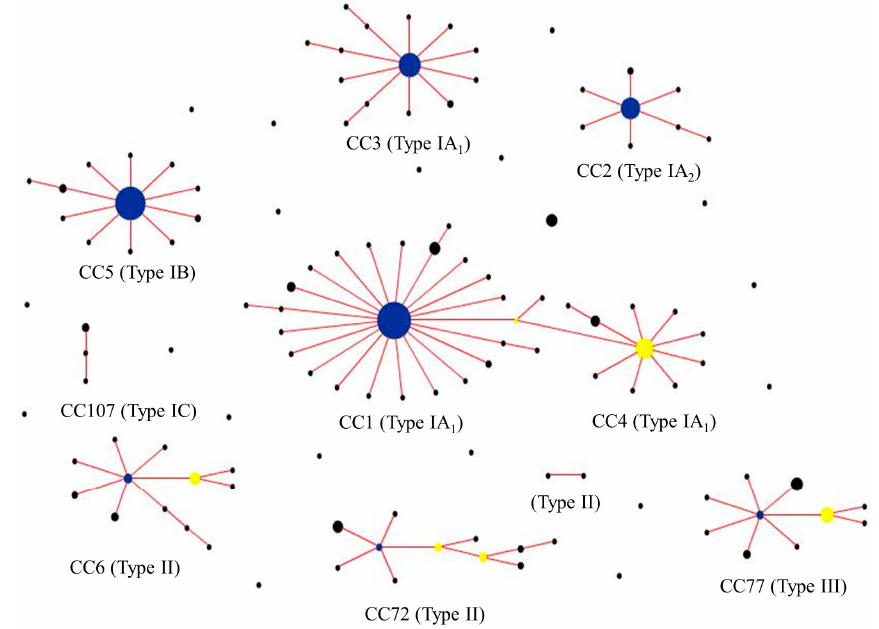
Figure 4. eBURST population snapshot of the current P. acnes MLST 8 database. To date, a total of nine clonal complexes, where the isolates share 7/8 loci with at least one other ST in the group, and 19 singletons have been identified from the analysis of over 400 isolates. Founding genotypes are highlighted in blue and sub-founders in yellow. The frequency of each ST is indicated by circle